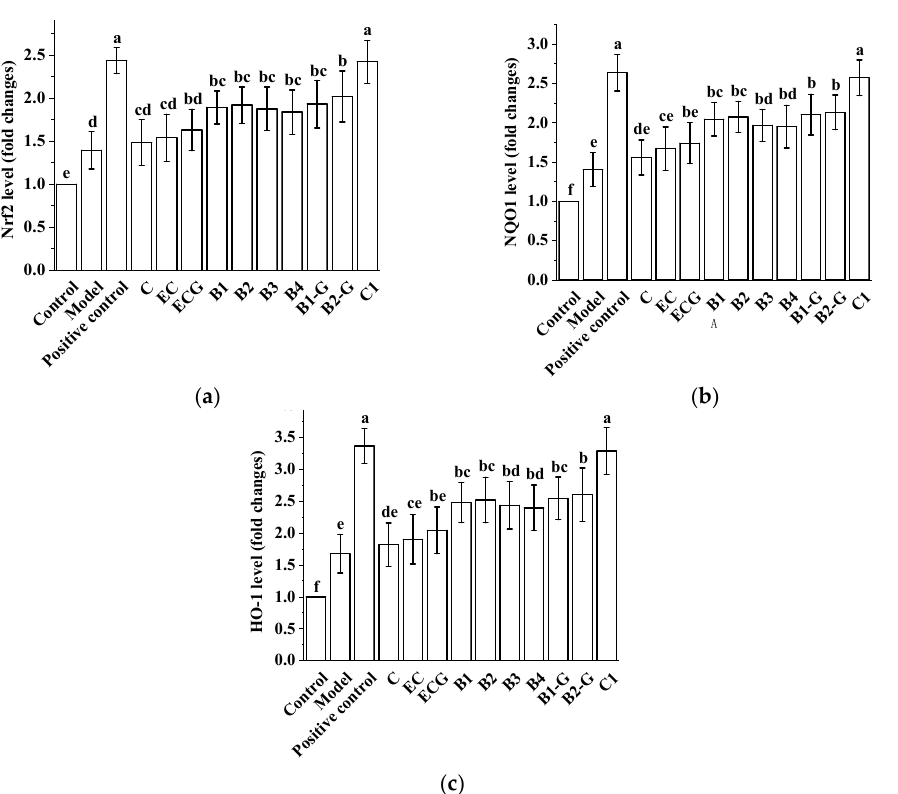
Figure 8. Effects of procyanidins with different structures on the Nrf2/ARE pathway in zebrafish treated with H 2 O 2 . ( a ) Nrf2 levels; ( b ) NQO1 levels; ( c ) HO-1 levels. Data are expressed as the mean ± SD. Control, Blank control group; Model, H 2 O 2 (300 μ M); Positive control, NAC (30 μ M) + H 2 O 2 (300 μ M); C, C (25 μ M) + H 2 O 2 (300 μ M); EC, EC (25 μ M) + H 2 O 2 (300 μ M); ECG, ECG (25 μ M) + H 2 O 2 (300 μ M); B1, B1 (25 μ M) + H 2 O 2 (300 μ M); B2, B2 (25 μ M) + H 2 O 2 (300 μ M); B3, B3 (25 μ M) + H 2 O 2 (300 μ M); B4, B4 (25 μ M) + H 2 O 2 (300 μ M); B1-G, B1-G (25 μ M) + H 2 O 2 (300 μ M); B2-G, B2-G (25 μ M) + H 2 O 2 (300 μ M); C1, C1 (25 μ M) + H 2 O 2 (300 μ M). All experiments were conducted three times. Values with different letters are significantly different ( p < 0.05, one-way ANOVA).